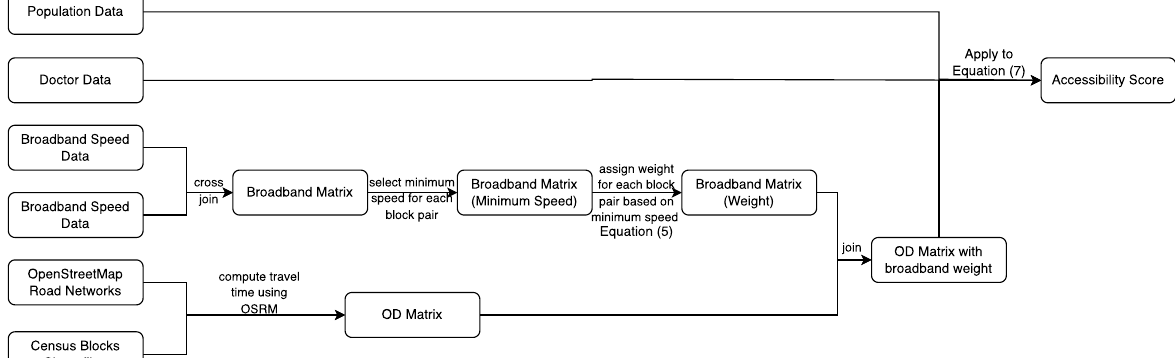
Fig. 2 Data processing flow